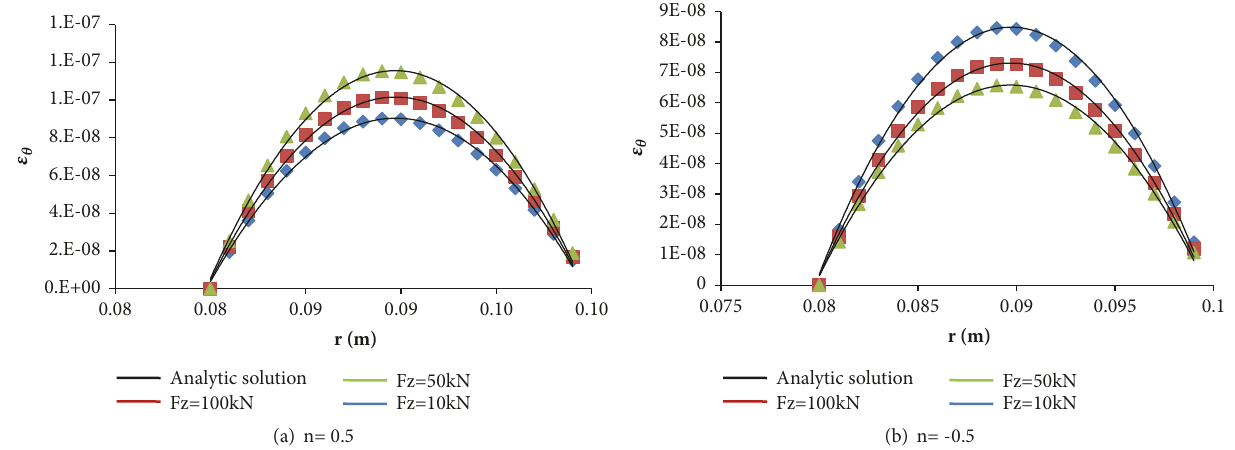
Figure 4: Tangential strain 𝜀 𝜃 as a function of radial coordinate: (a) for n=0.5 , (b): n=-0.5